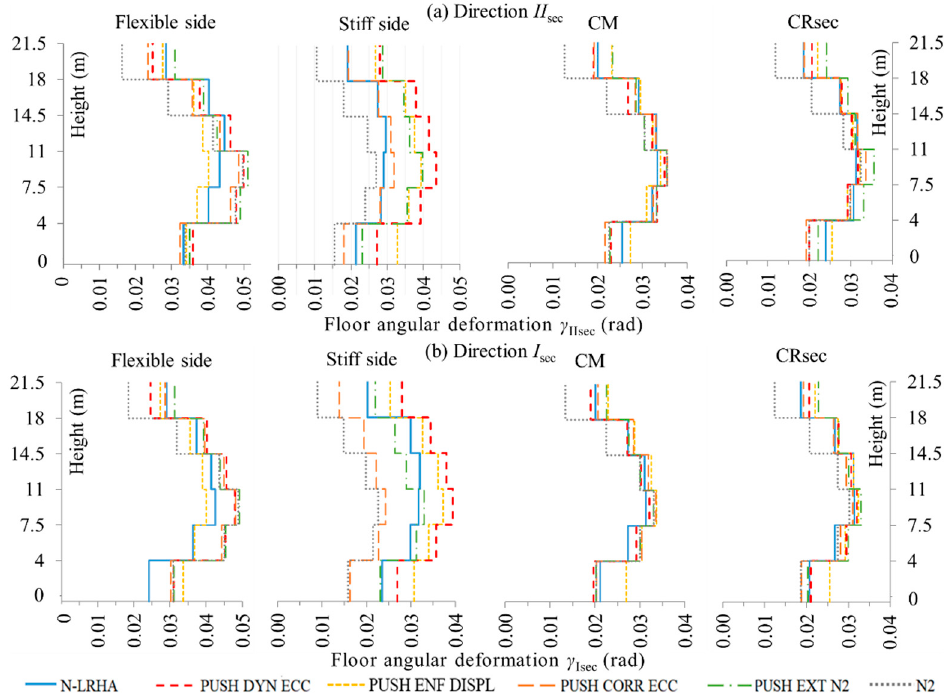
Figure 15. Comparison of floor angular deformations at NC resulted from the examined pushover procedures and N-LRHA for case 1: ( a ) γ IIsec along the II sec axis, ( b ) γ Isec along the I sec axis.